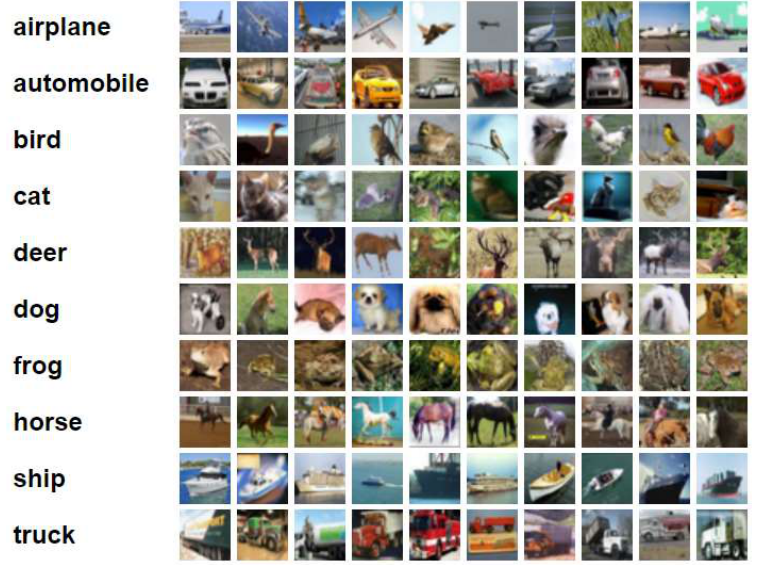
Figure 1. CIFAR-10 data set image sample.